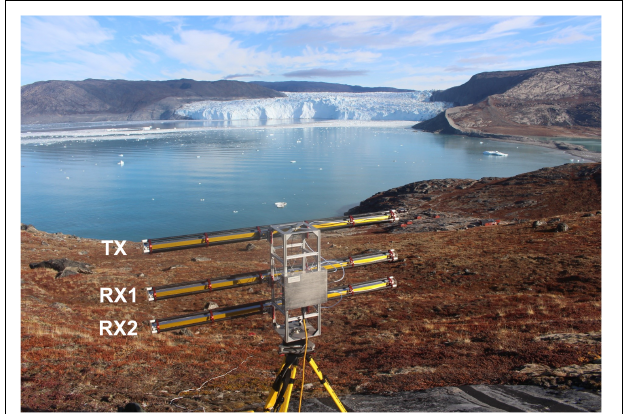
FIGURE 2 | The terrestrial radar interferometer (TRI) with one transmitting (TX) and two receiving antennas (RX1, RX2) is located opposite of the front of Eqip Sermia at a distance of 4.5